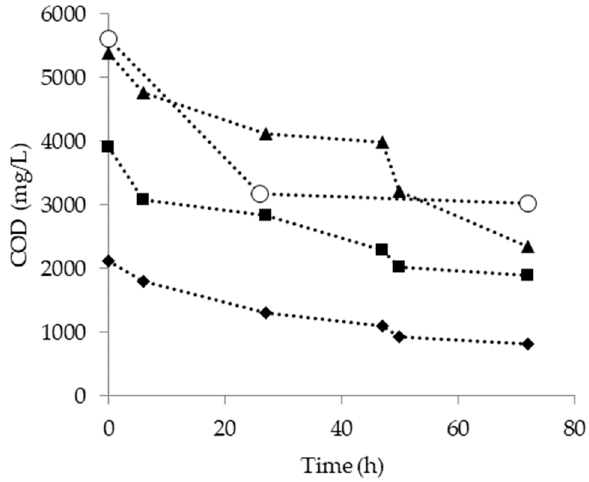
Figure 2. Chemical oxygen demand (COD) removal trends during the aerobic treatment of pyrolysis wastewater at 30 °C (TOC initial concentration: ( ♦ ) 800 mg/L, ( ■ ) 1400 mg/L, ( ▲ ) 2000 mg/L and ( ○ ) 2800 mg/L).